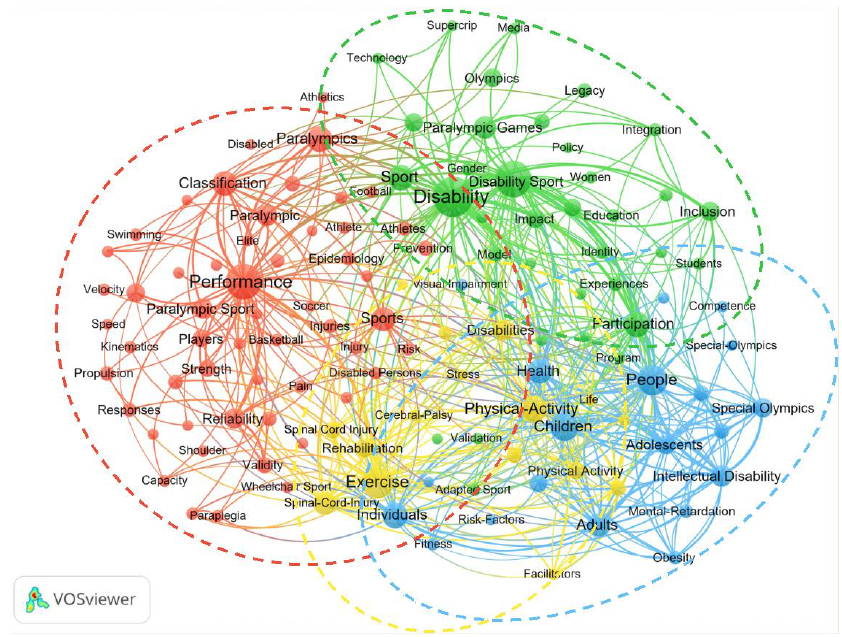
Figure 6. Keywords co-occurrence analysis of adapted sport publications between 2001 and 2020.